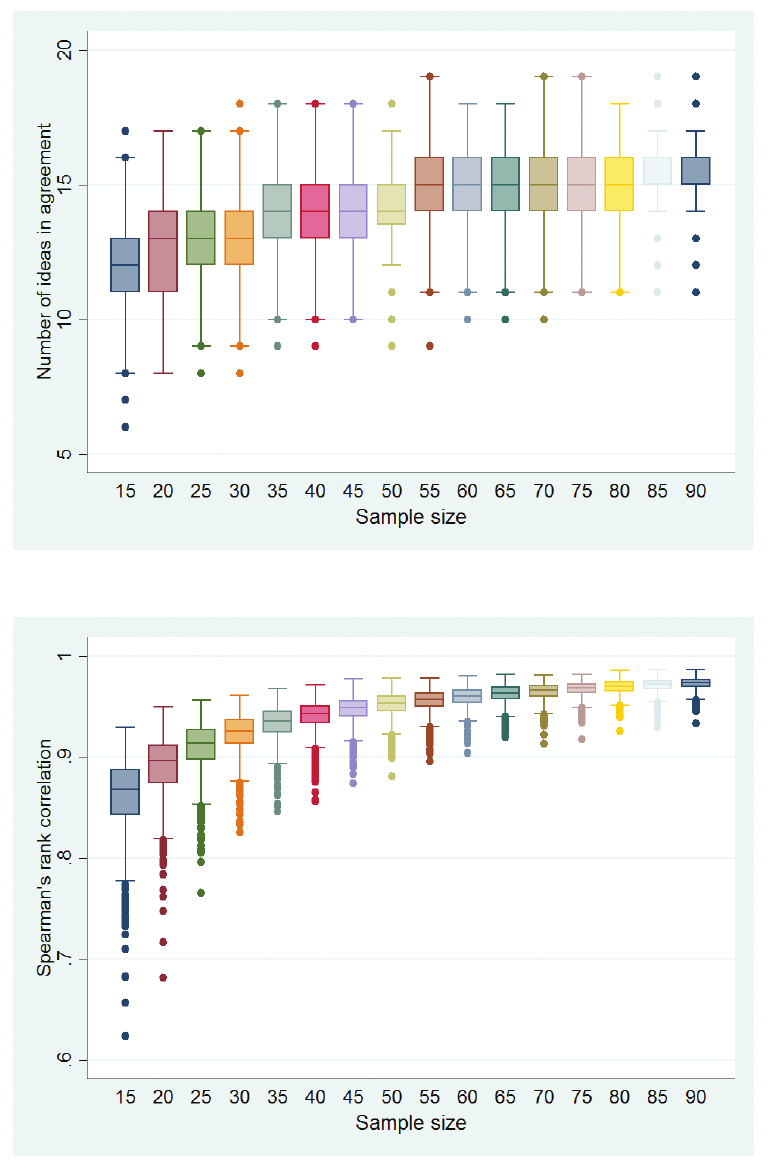
Figure 2 . Spearman’s rank correlation among all 205 ranked research ideas (Y–axis) by the size of the sample of randomly selected experts (X–axis) from a total pool of 91 experts using a bootstrap method (simulation 1000 times with replace- ment of already selected experts, using bsam- pling function). The size of randomly generated samples ranged from 15 to 90 and it was based on the CHNRI exercise on newborn health research priorities